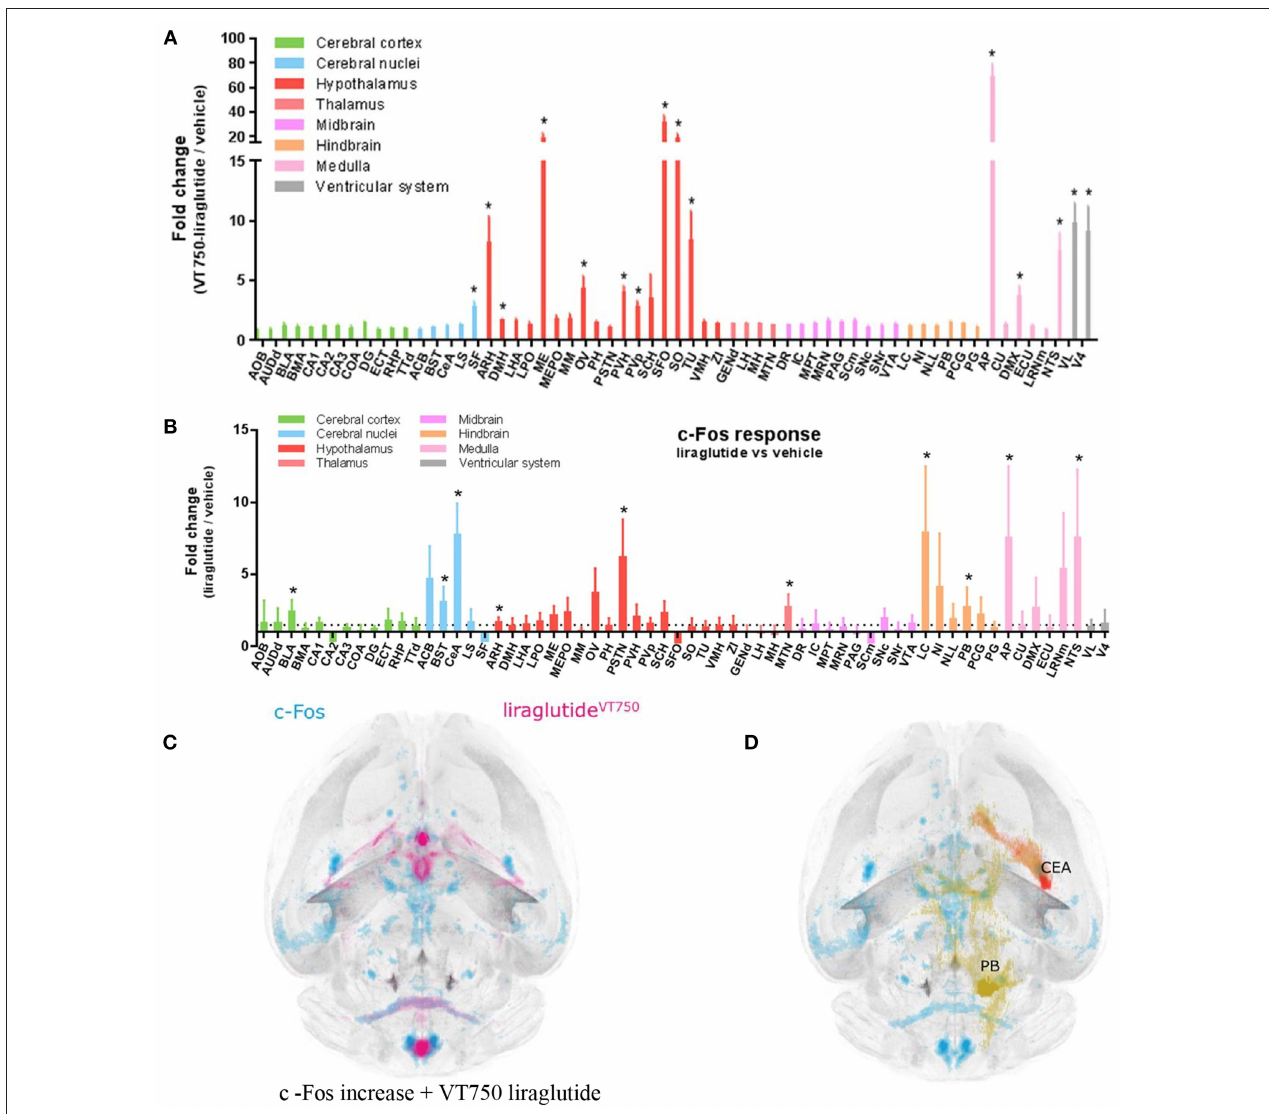
FIGURE 9 | Liraglutide, cFOS, and the hindbrain. Brain region with liraglutide VT750 access. Bar graph (A) shows the mean fold change and standard deviation (SD) of the total fluorescence signal in selected brain regions comparing liraglutide VT750 and vehicle ( n = 5). An asterisk marks significant difference between treatments when analyzed in individual brain regions using a false discovery rate value of 5% to correct for multiple comparisons. Note the split y-axis when interpreting result and standard deviation. Neural activation following liraglutide administration. Bar graph (B) shows the mean fold change SD to total c-Fos heat map signal in selected brain regions comparing liraglutide- and vehicle-dosed animals. Regions were selected as having either liraglutide VT750 access, GLP-1R expression, or c-Fos response. An asterisk marks significant difference between treatments when analyzed in individual brain regions using a false discovery rate value of 20% to correct for multiple comparisons. (C) Liraglutide-specific c-Fos increase overlaid with the average liraglutide VT750 distribution from bar graph (B) . (D) Connectivity maps visualized by horizontal maximum intensity projection overlaid with the average c-Fos increase following liraglutide administration from (C) . ACB, nucleus accumbens; AOB, accessory olfactory bulb; AP, area postrema; ARH, arcuate hypothalamic nucleus; AUDd, dorsal auditory area; BLA, basolateral amygdalar nucleus; BMA, basomedial amygdalar nucleus; BST, bed nuclei of the stria terminalis; CA (1, 2, and 3), field CA(1, 2, and 3); CeA, central amygdalar nucleus; COA, cortical amygdalar area; CU, cuneate nucleus; DG, dentate gyrus; DMH, dorsomedial nucleus of the hypothalamus; DMX, dorsal motor nucleus of the vagus nerve; DR, dorsal nucleus raphe; ECT, ectorhinal area; ECU, external cuneate nucleus; GENd, geniculate group, dorsal thalamus; IC, inferior colliculus; LC, locus ceruleus; LH, lateral habenula; LHA, lateral hypothalamic area; LPO, lateral preoptic area; LRNm, lateral reticular nucleus, magnocellular part; LS, lateral septal nucleus; ME, median eminence; MEPO, median preoptic nucleus; MH, medial habenula; MM, medial mammillary nucleus; MPT, medial pretectal area; MRN, midbrain reticular nucleus; MTN, midline group of the dorsal thalamus; NI, nucleus incertus; NLL, nucleus of the lateral lemniscus; NTS, nucleus of the solitary tract; OV, vascular organ of the lamina terminalis; PAG, periaqueductal gray; PB, parabrachial nucleus; PCG, pontine central gray; PG, pontine gray; PH, posterior hypothalamic nucleus; PSTN, parasubthalamic nucleus; PVH, paraventricular hypothalamic nucleus; PVp, periventricular hypothalamic nucleus, posterior part; RHP, retrohippocampal region; SCm, superior colliculus, motor related; SCH, suprachiasmatic nucleus; SF, septofimbrial nucleus; SFO, subfornical organ; SNc, substantia nigra, compact part; SNr, substantia nigra, reticular part; SO, supraoptic nucleus; TTd, taenia tecta, dorsal part; TU, tuberal nucleus; VL, lateral ventricle; VMH, ventromedial hypothalamic nucleus; VTA, ventral tegmental area; ZI, zona incerta; V4, fourth ventricle. Reproduced from Salinas et al. (200). Creative common license available at: http://creativecommons.org/licenses/by/4.0/.